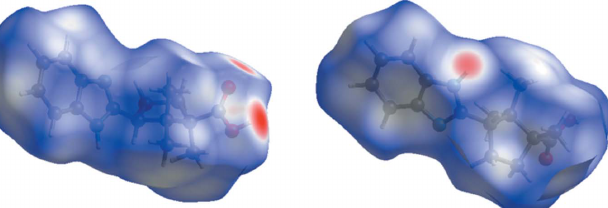
Figure 5 Two orientations of the Hirshfeld surface for the title compound mapped over d norm .